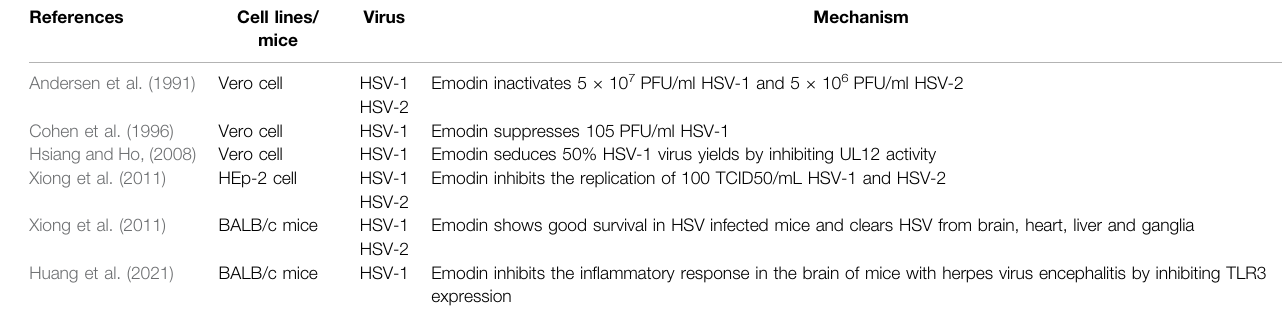
TABLE 1 | Anti-HSV activities of